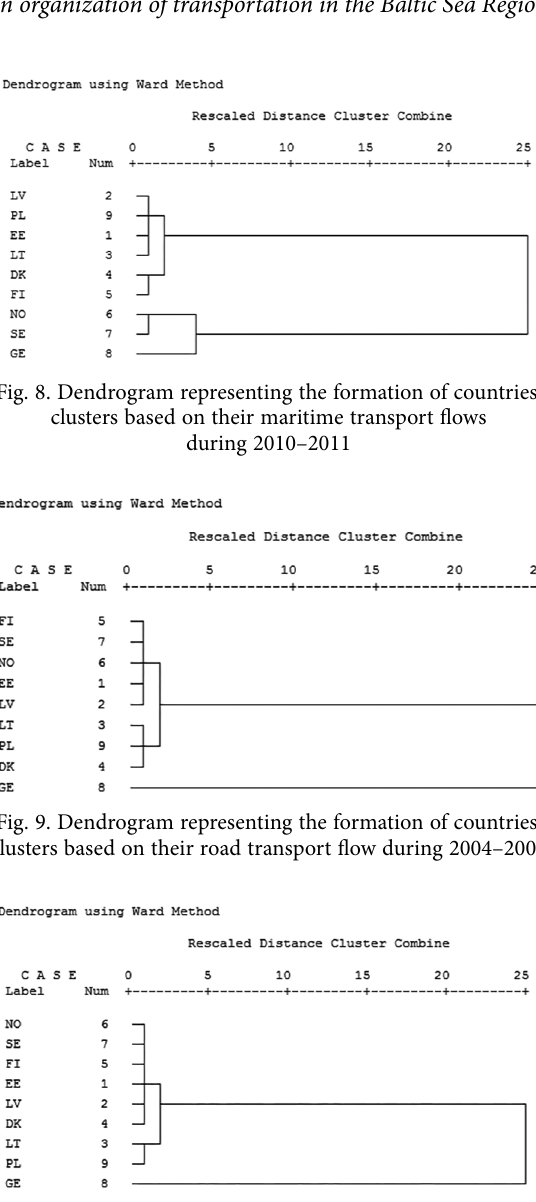
Fig. 10. Dendrogram representing the formation of countries’ clusters based on their road transport flow during 2008–2009